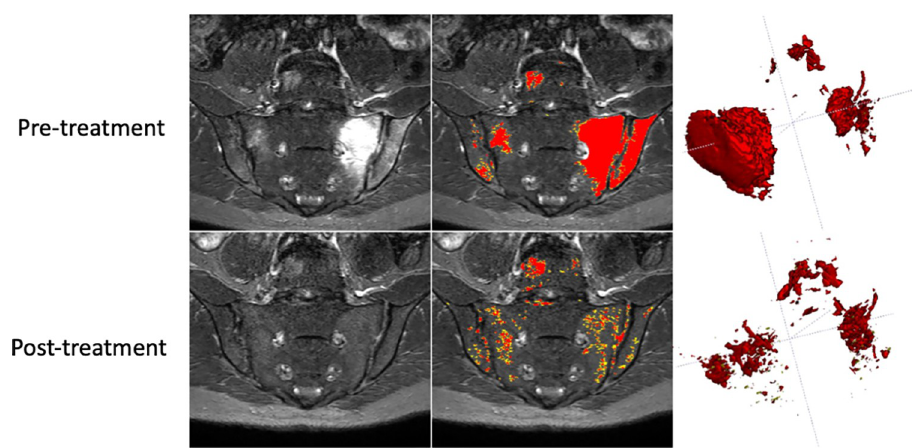
Fig 8. Example of response to biologic therapy. Pre- and post-treatment scans for a single subject are shown (top and bottom row respectively). The left-hand column shows the STIR images, the middle column shows the preliminary segmentations (not cleaned to provide a demonstration of the performance of the automated component) and the right column shows visual summaries of the disease volume. Regions of acute inflammation showed a reduction in extent and intensity after treatment, although there is a persistent, slight hyperintensity compared to the normal interforaminal bone, which manifests as an increase in the proportion of inflammation captured by the lower (yellow) of the two thresholds (see Details of Step (ii)–Thresholding within disease